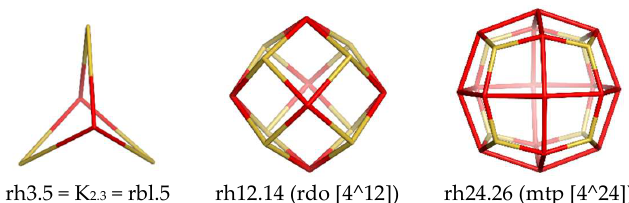
Figure 1. Rhomb tessellated units.